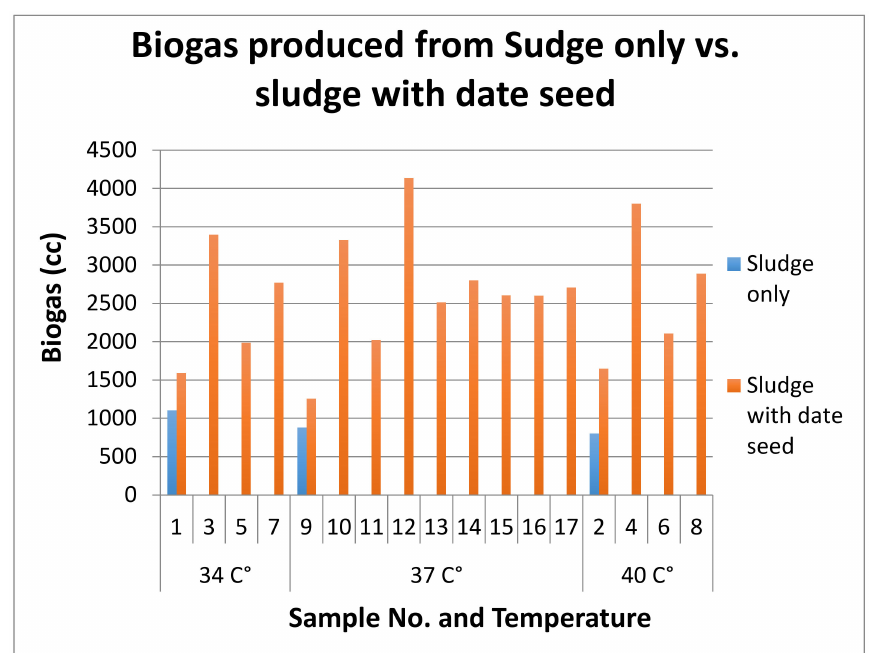
Figure 3. Biogas yield from sludge only and after adding date